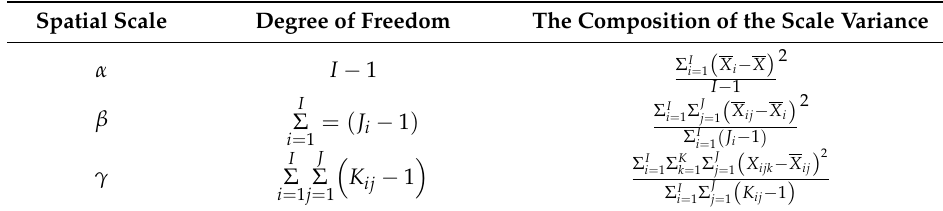
Table 1. Scale variance composition at different scales. Spatial Scale Degree of